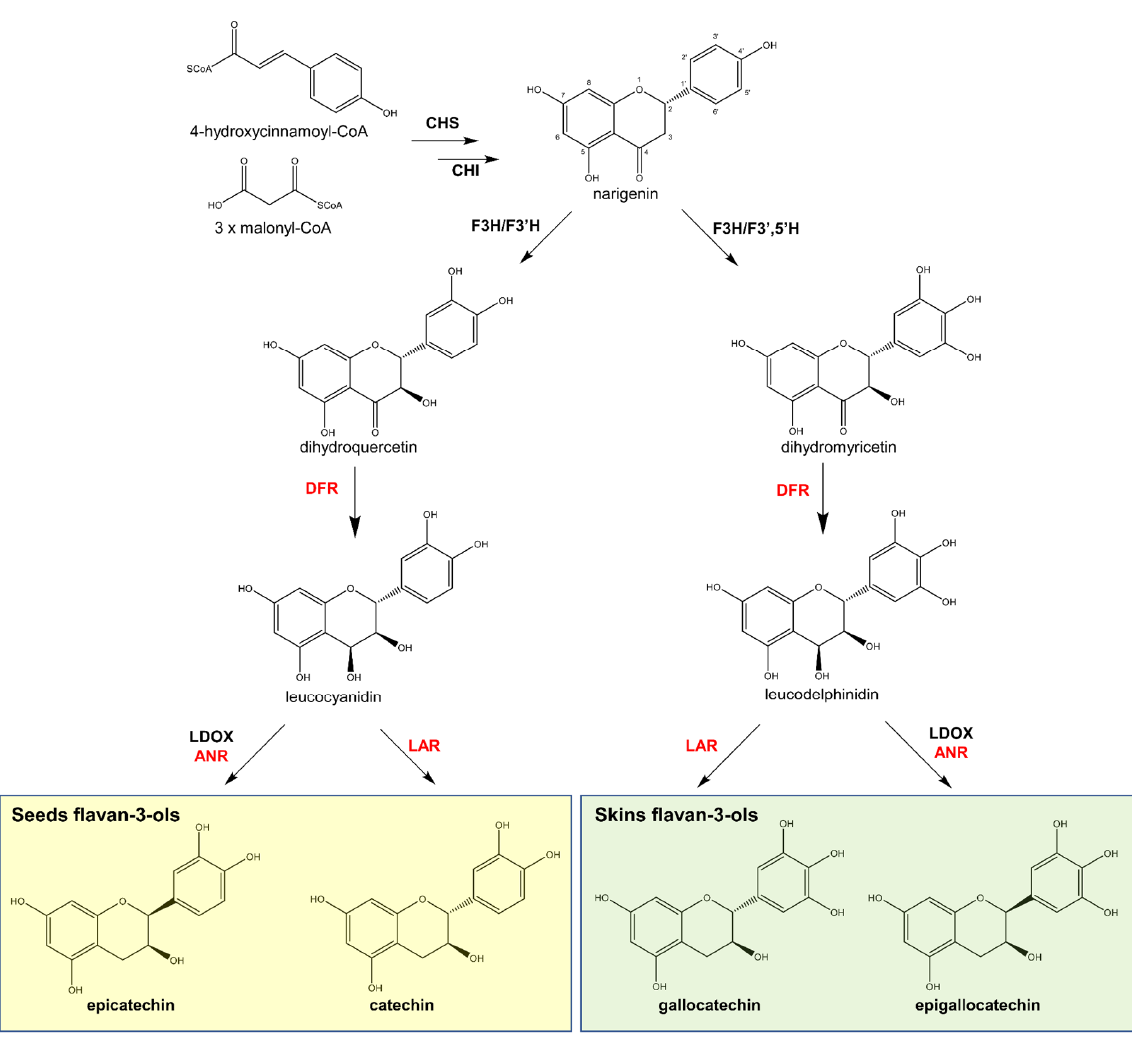
Figure 5. Biosynthetic route of flavan-3-ols in grape. Enzymes: Chalcone synthase (CHS), chalcone isomerase (CHI), flavanone 3-hydroxylase (F3H) and flavanone 3 ′ -hydroxylase (F3 ′ H), flavanone 3 ′ ,5 ′ -hydroxylase (F3 ′ 5 ′ H), dihydroflavonol 4-reductase (DFR), leucoanthocyanidin dioxygenase (LDOX), and anthocyanidin reductase (ANR) [5,57,58].